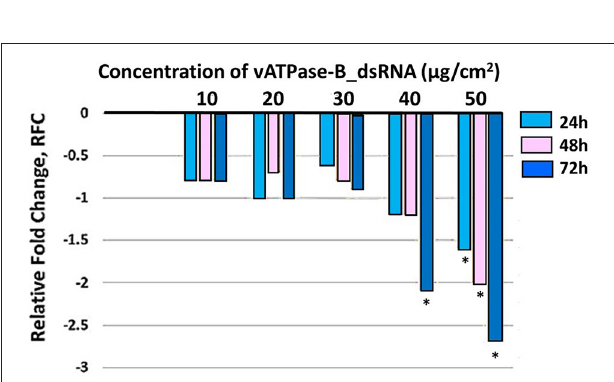
FIGURE 4 | Relative fold change in expression of v-ATPase B transcript in T. absoluta larvae post feeding post treatment. Comparing relative expression of controls (set to “0,” to all other concentration treatments, at each of three time-points during feeding access period). RT-qPCR was used to quantify expression levels with internal control ( β actin). Treatment concentrations were 10, 20, 30, 40, and 50 µ g/ cm 2 leaf). Relative expression levels were determined with respect to control larvae fed on untreated tomato leaves. Analysis within each time-point across treatments compared to control was carried out by a one-way ANOVA (*P < 0.0001) multiple comparison test (n = 9) biological replicates, with three technical replicates.